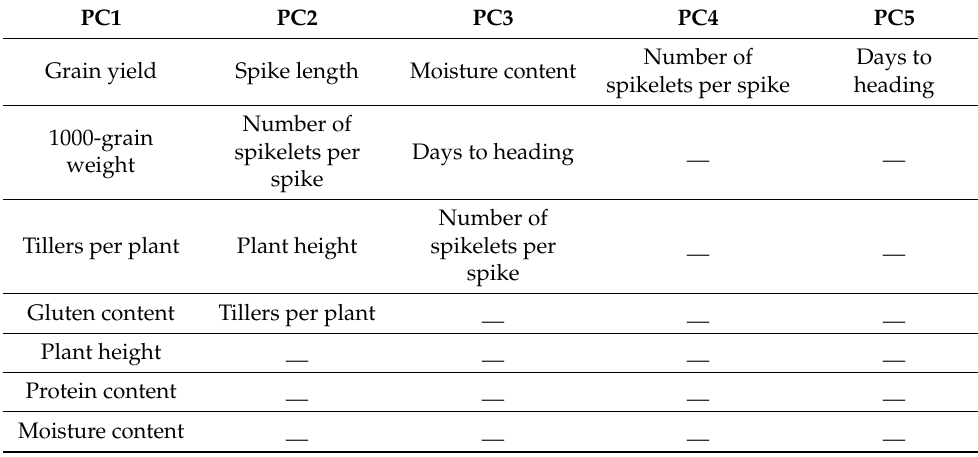
Table 7. Rotation component matrix of different traits with Eigen values > 0.5 in the first five